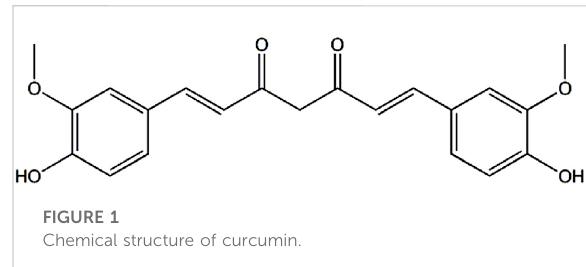
FIGURE 1 Chemical structure of curcumin.